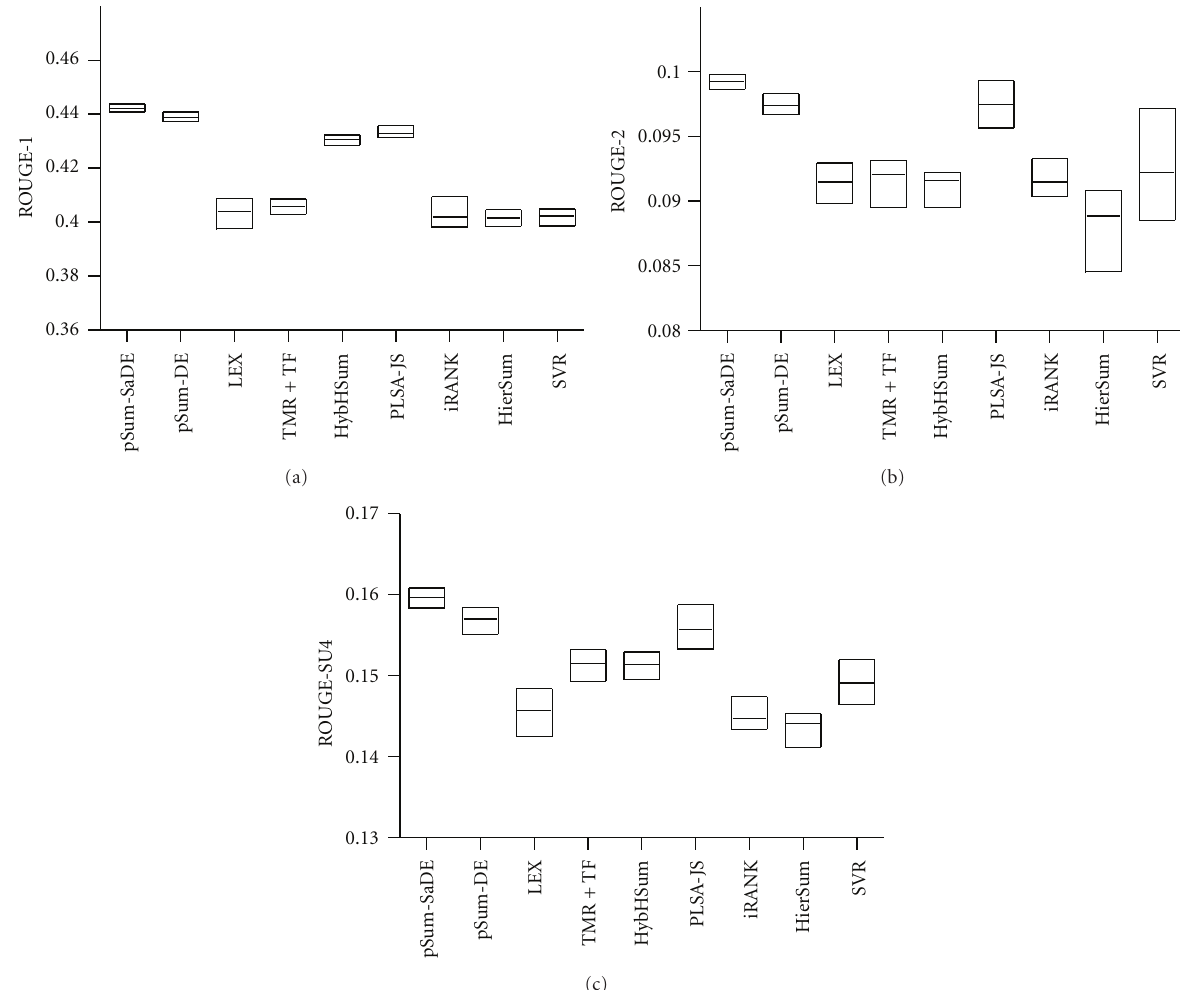
Figure 2: Change of ROUGE-1, ROUGE-2, and ROUGE-SU4 for di ff erent summarization methods.